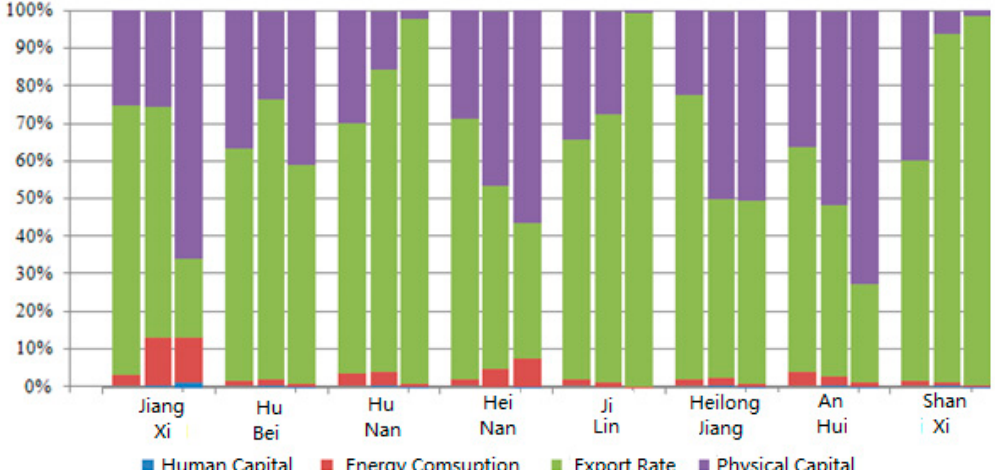
Figure 7. Contribution variables to FDI performance in the midland.